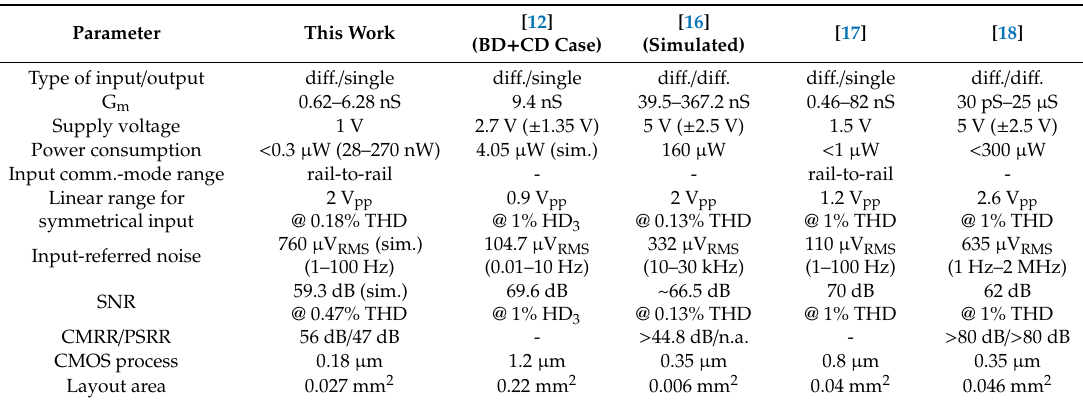
Table 2. Comparison of linear LTAs (linear low-G m